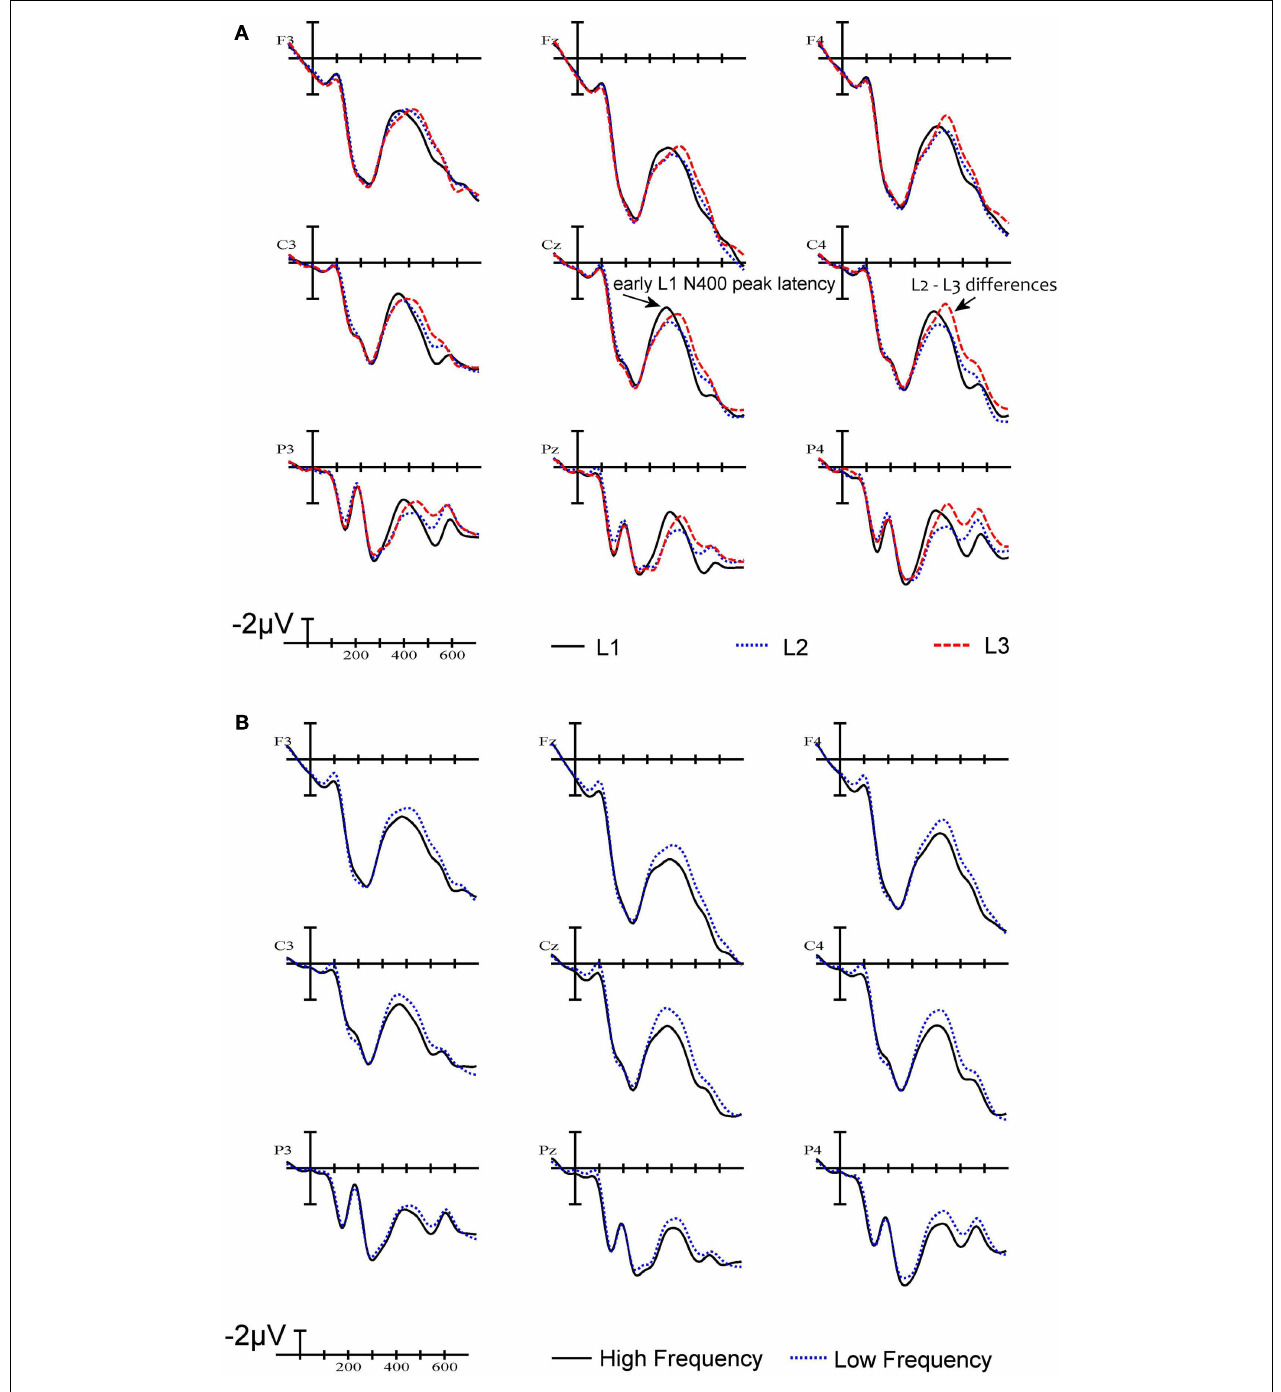
FIGURE 3 | Grand average waveforms. (A) ERPs to words in L1 (French), L2 (English), and L3 (Spanish) at nine electrode sites. (B) ERPs to high frequency words and low frequency words.The X -axis indicates time from stimulus onset in milliseconds.